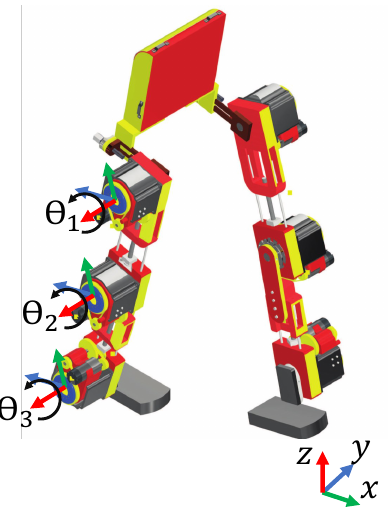
Figure 4. Generalized coordinate distribution.